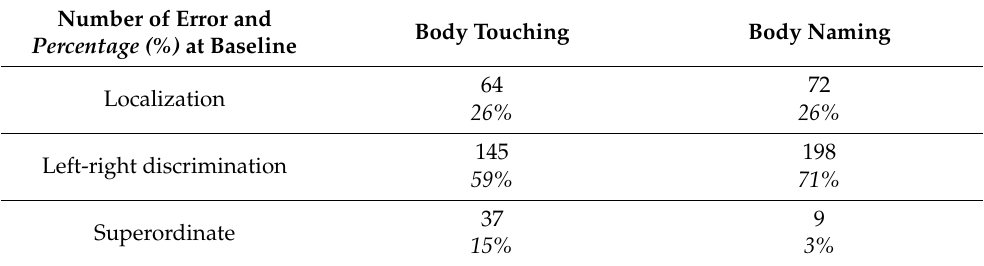
Table 1. Error types at